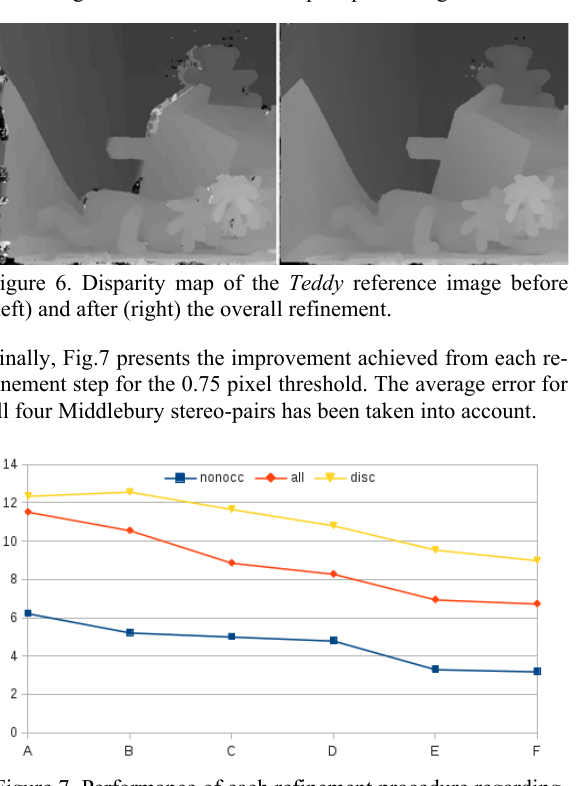
Figure 7. Performance of each refinement procedure regarding disparity map accuracy for the 0.75 pixel threshold, seen as a- verage error for four Middlebury datasets (% of wrong